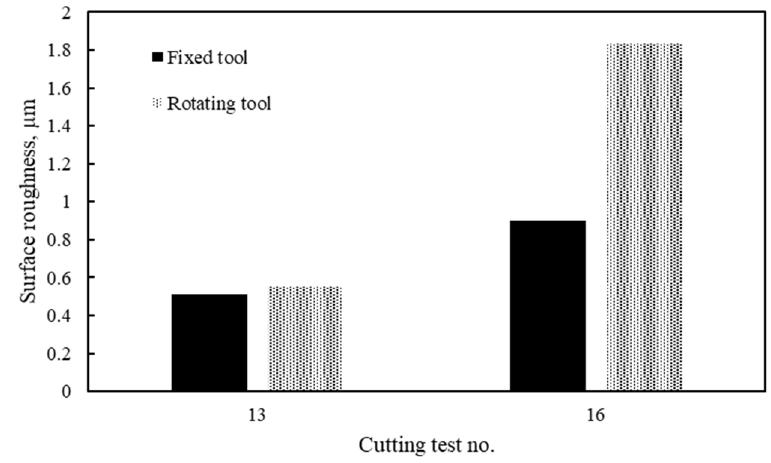
Figure 5. Average surface roughness results at worst and best scenarios for rotary tool versus fixed tool.